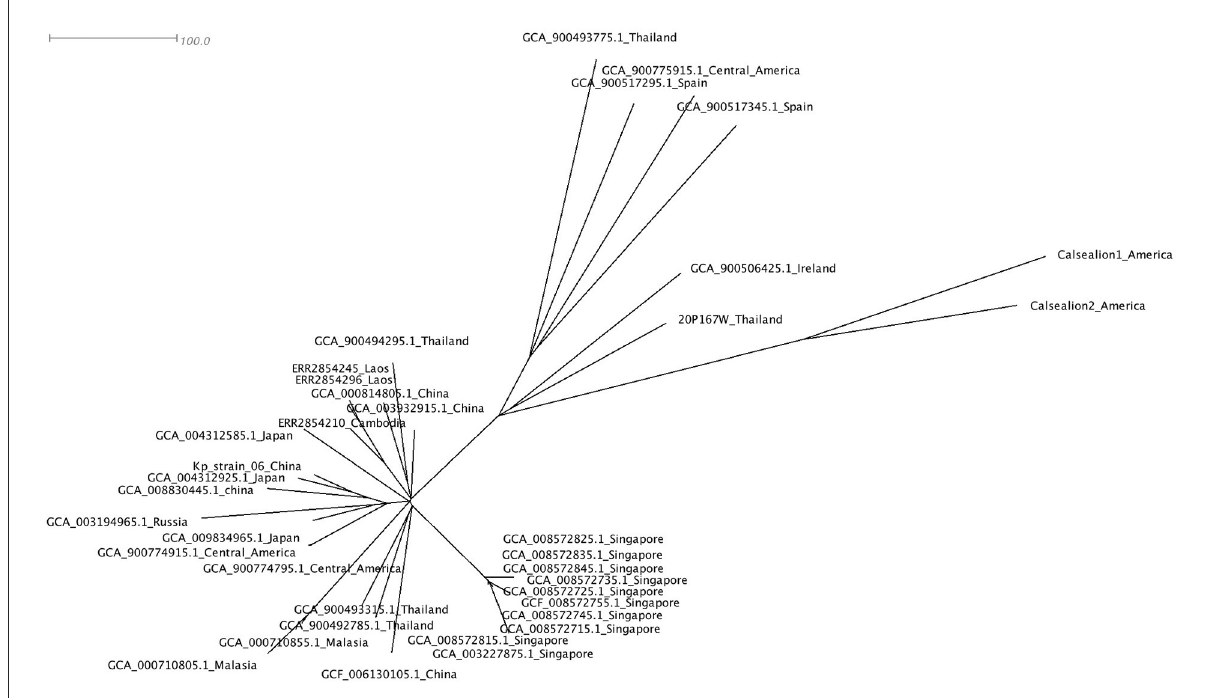
FIGURE5 Data of virulence and antimicrobial resistance genes of each strain: rectangular represented rmpA and rmpA2 genes, siderophore gene cluster including yersiniabactin, aerobactin, and salmochelin, fimbriae gene cluster, colibactin gene cluster, and antimicrobial resistance